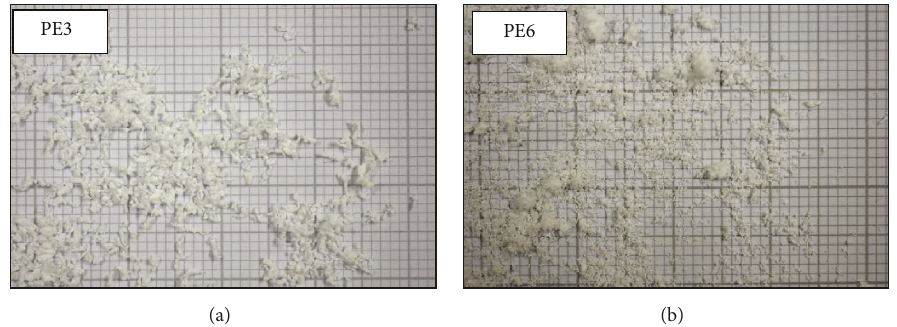
Figure 5: Nascent particles of UHMWPE obtained from pure toluene (PE3, a) and pure heptane (PE6, b).